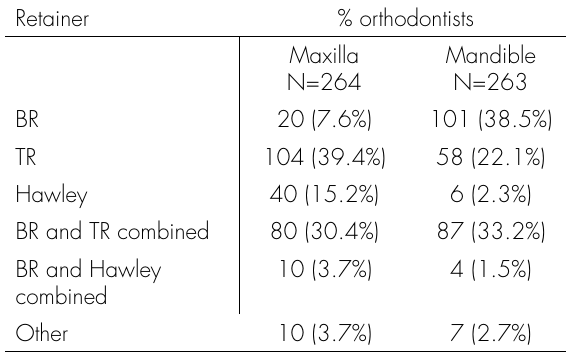
BR: bonded retainer. RR: removable